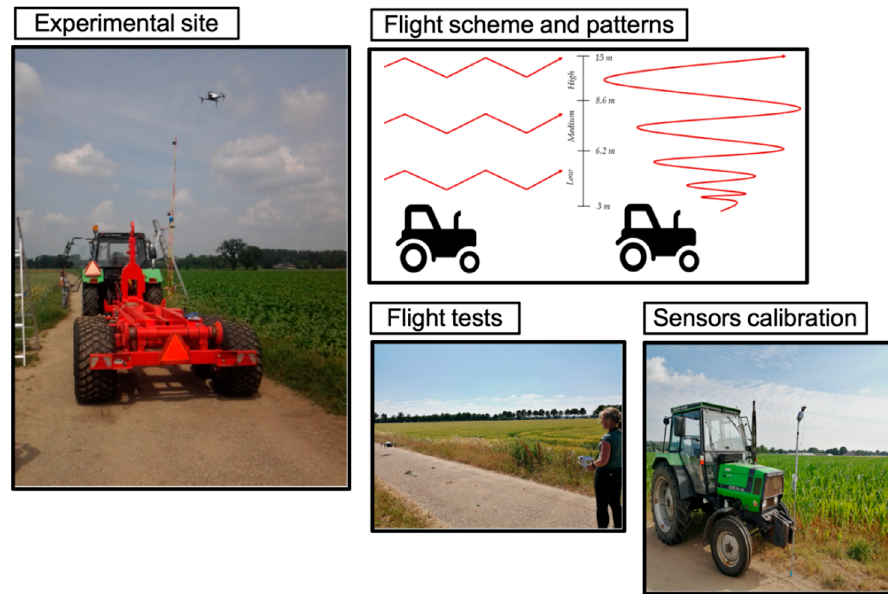
Figure 2. Experimental setup: Experimental site where the experiments were carried out; Flight scheme and patterns (zigzag and spiral); Flight tests for testing the sensors and communication with the base station; Sensors calibration for setting a threshold for the measurements.